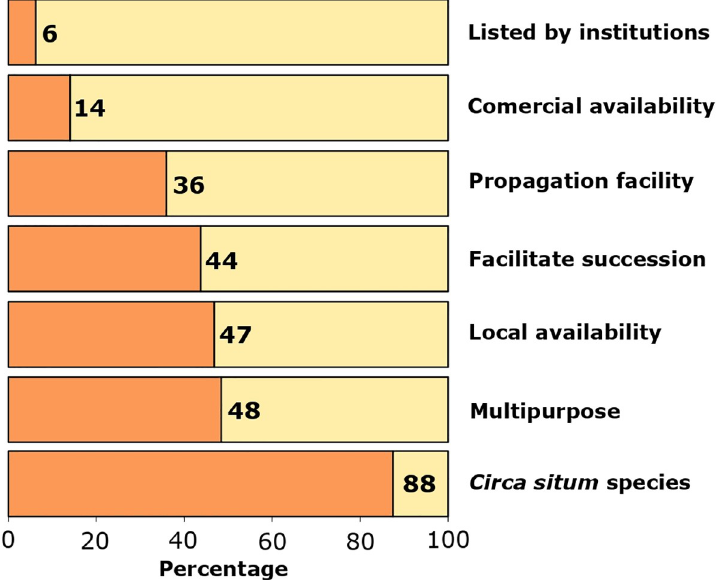
Fig 1. Criteria used for biological material selection in the restoration projects. (i) circa situm : Species within to the restoration zone (natives or naturalized), (ii) multipurpose species, (iii) local availability of seeds and seedlings (extracted from reference neighborhood or nearby sites), (iv) species that facilitate succession (nursery plants or catalyzing species, for example, species producing fruits that feed local fauna, nitrogen fixers, soil fixers, etc.), (vi) ease of propagation or reproduction, (vii), commercial availability of seeds or germplasm, and (viii) listed species by convener institutions. The total number of projects analyzed was 64.